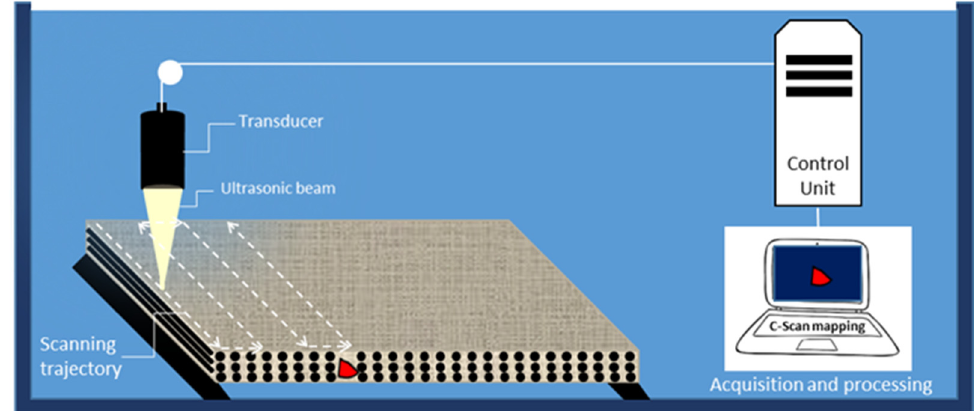
Figure 6. Principle of ultrasonic testing (C-scan example).